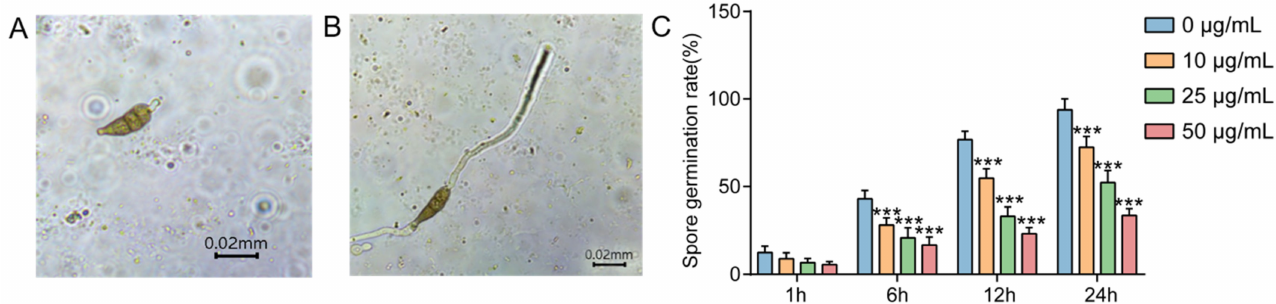
Figure 4. Effects of compound 4 on spore germination of A. solani. ( A ) The fungal spores treated with compound 4 at the IC 50 concentration for 12 h. ( B ) The untreated spore germination (control). ( C ) Spore germination rate when treated with different concentrations of compound 4 at different hours. *** indicates a significant difference ( p < 0.001).